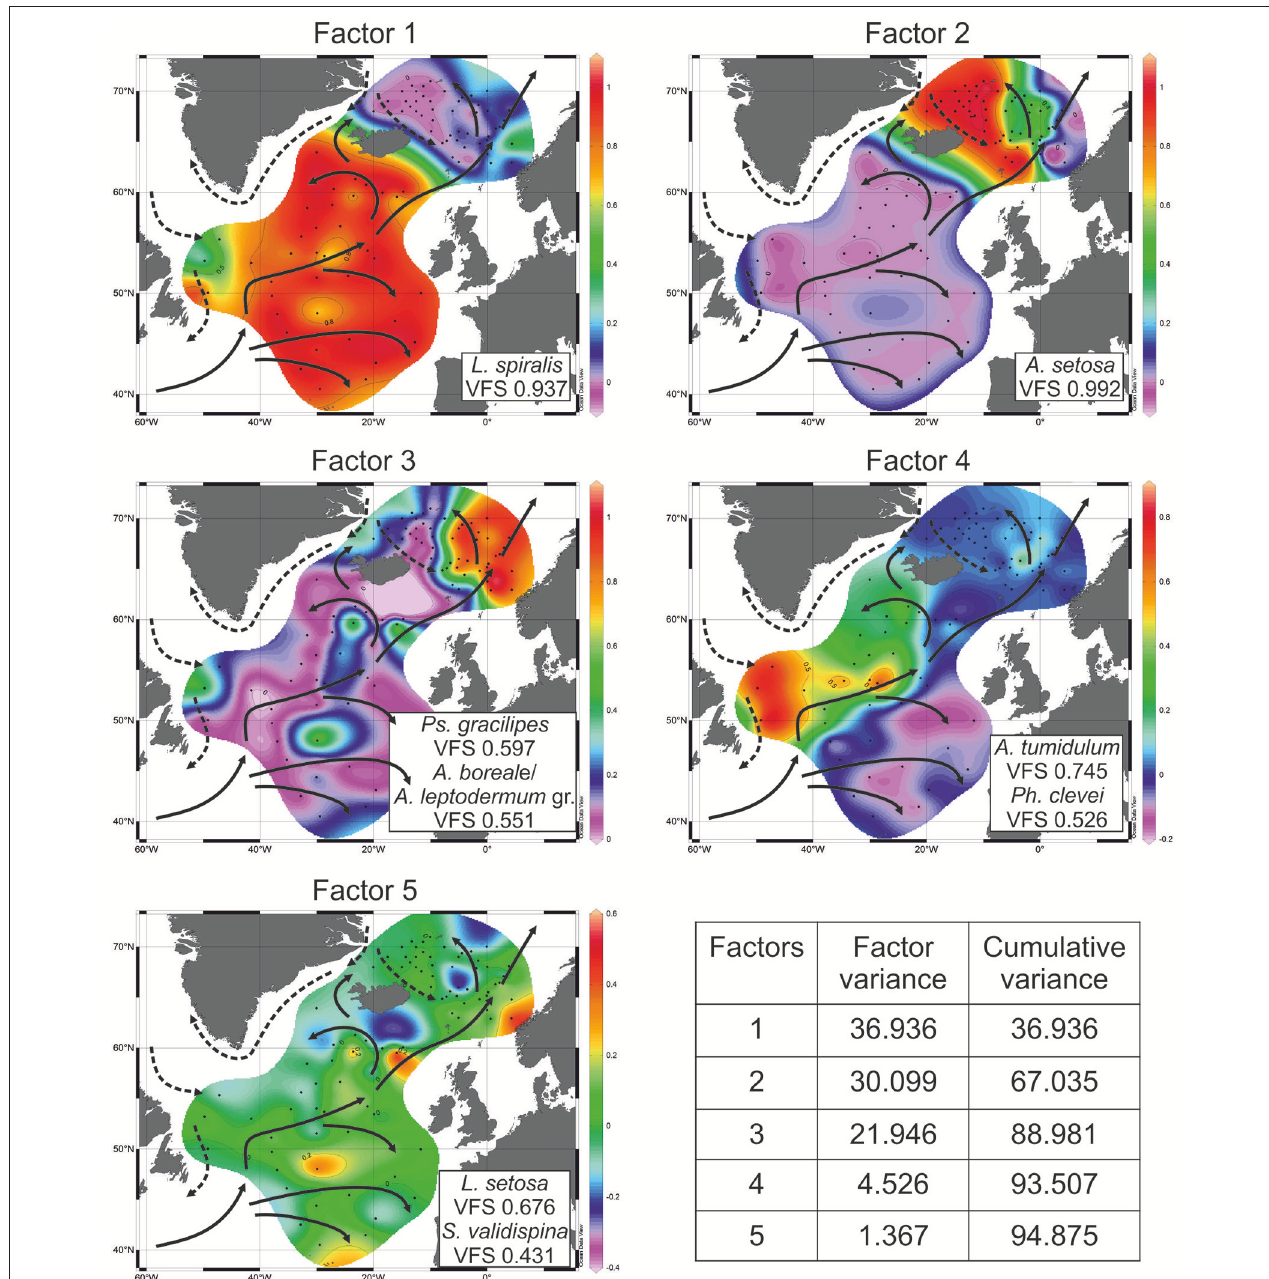
FIGURE 4 | Distribution of factor loadings. VFS, varimax factor score. Sea surface (0m) circulation according to Gorshkov et al. (1977): solid arrows—warm currents, dashed arrows—cold